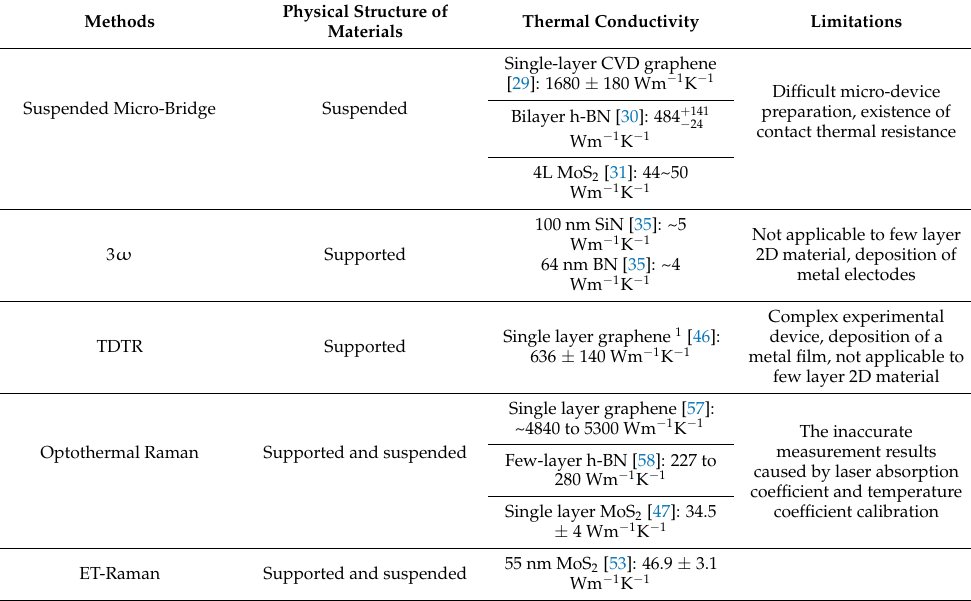
Figure 11. ( a ) Energy transport process among different energy carriers in suspended 2D materials under laser irradiation. ( b ) The temperature difference between OP and AP against laser spot size. ( c ) Acquisition of thermal conductivity of 2D materials and coupling coefficient between OP and AP. Reprinted with permission from Ref. [53]. Copyright 2020, John Wiley and Sons. Table 1. Application and comparison of various experimental